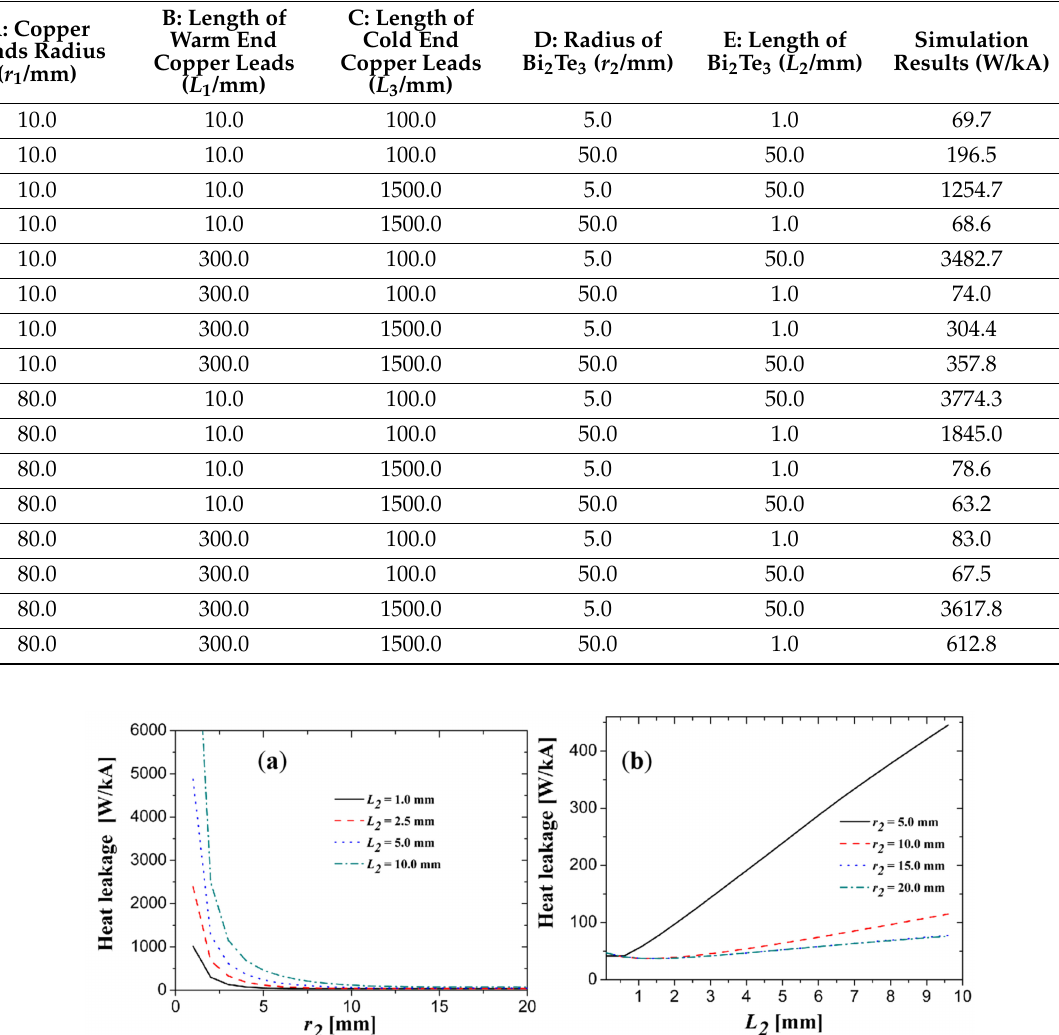
Figure A7. The coupling influence between D ( r 2 ) and E ( L 2 ) on the cold end heat leakage of PCLs. ( a ) The heat leakage vary with D ( r 2 ); ( b )The heat leakage vary with E ( L 2